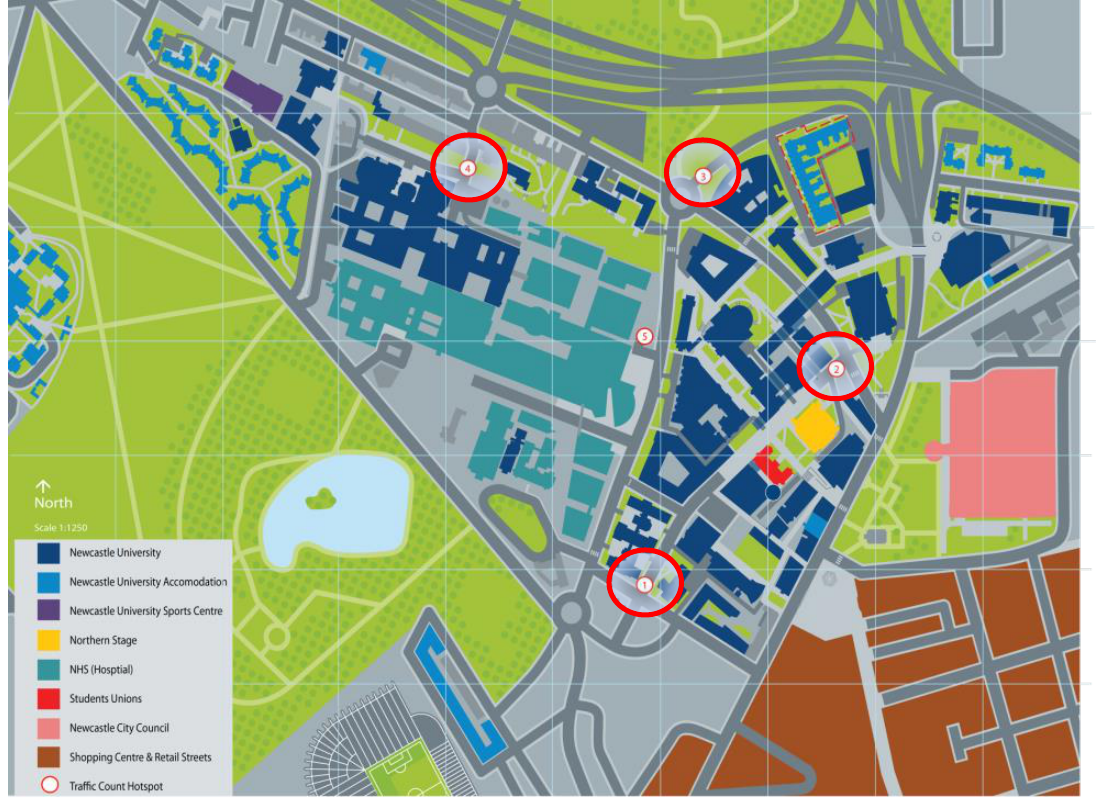
Figure 1. Main campus of Newcastle University with traffic count points